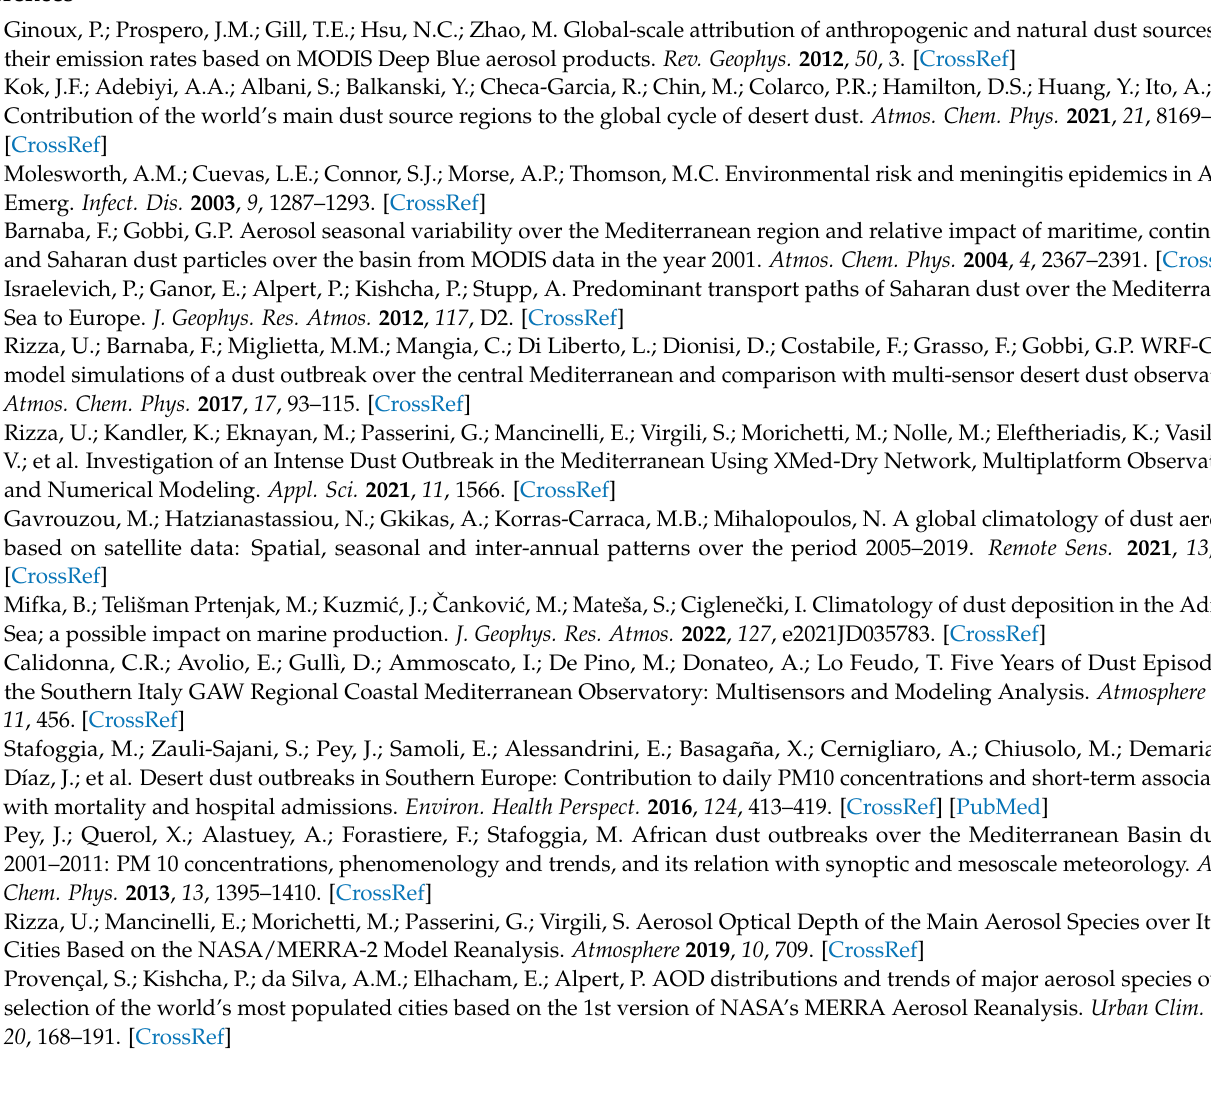
NUTS—Nomenclature of territorial units for statistics of the European